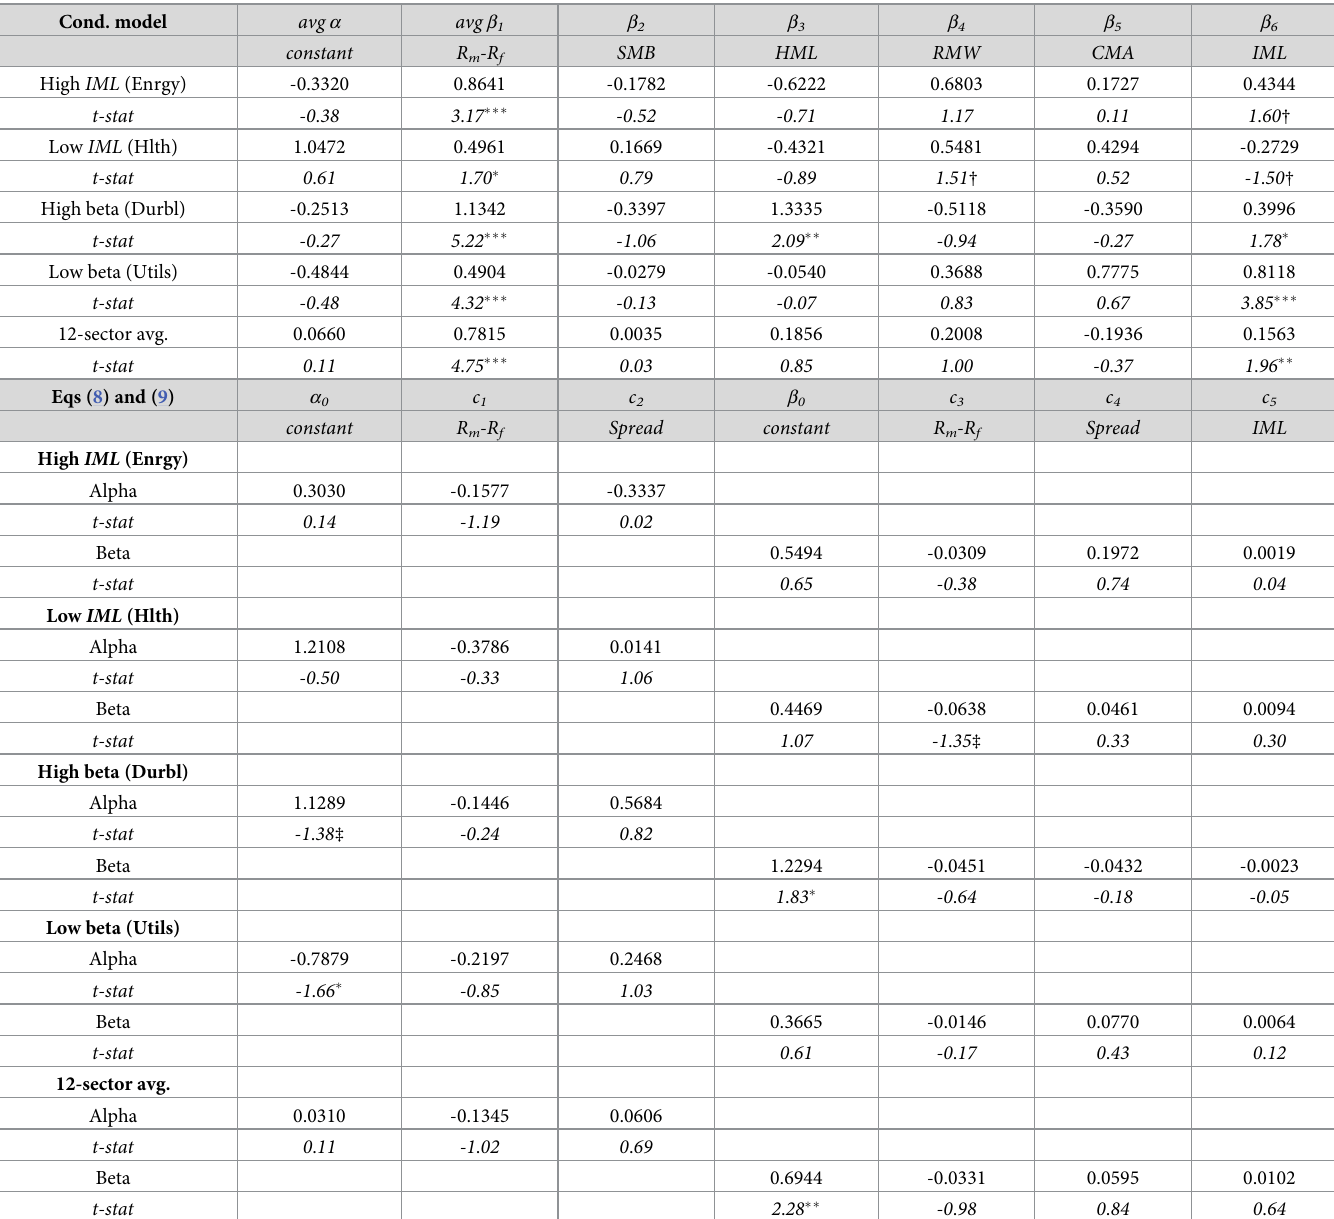
Table 4. Parameter estimations for the conditional Fama-French model via RIV GMM by liquidity and beta attributes. Cond.